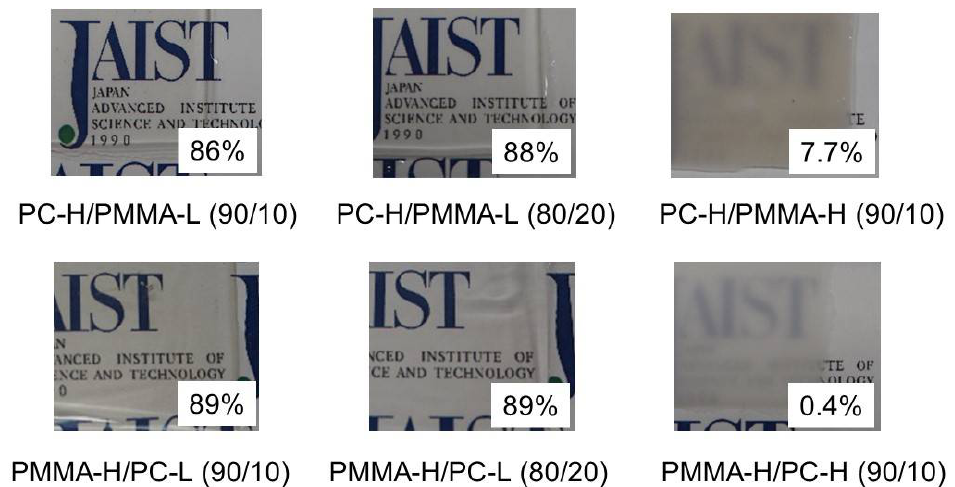
Figure 2. Photographs of sample films prepared by compression molding. The numbers in the figure represent the light transmittance at 589 nm.